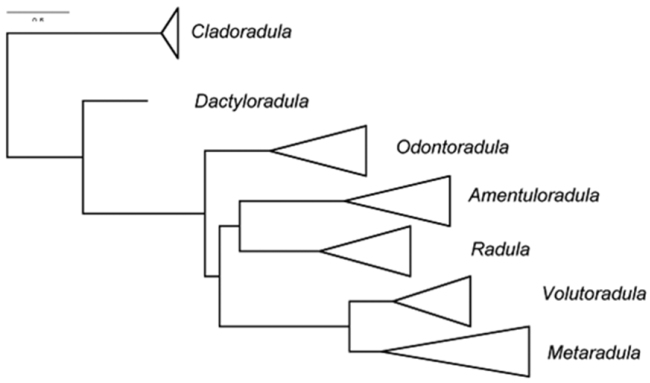
Relationships between seven subgenera identified within Radula by Devos et al. (2011a, b).